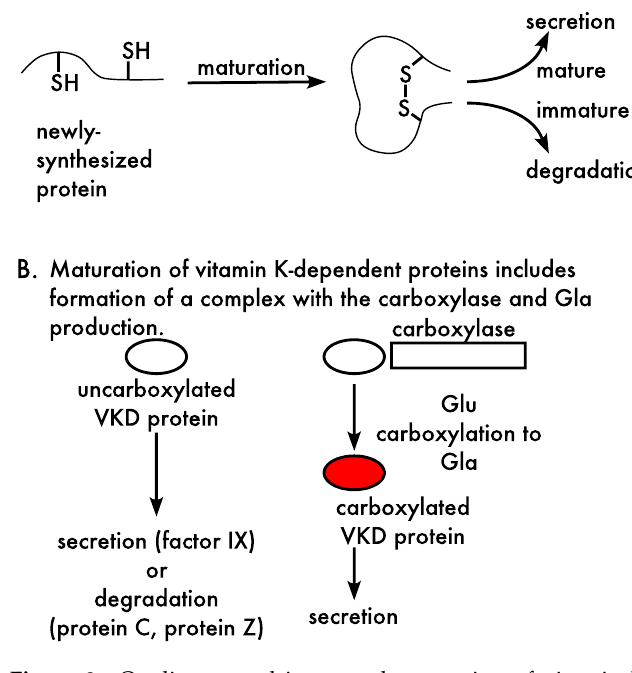
Figure 3. Quality control impacts the secretion of vitamin K-dependent proteins. ( A ) Newly-synthesized proteins undergo maturation that is mediated by chaperones and involves protein folding and, in some cases, disulfide bond formation and the assembly of complexes. Quality control mechanisms distinguish mature versus immature proteins, which are processed differently. Mature proteins exit the endoplasmic reticulum and traffic to the Golgi and beyond, while immature proteins are targeted for degradation through the ERAD pathway. ( B ) Vitamin K-dependent (VKD) protein maturation also includes Glu carboxylation to Gla that occurs in the endoplasmic reticulum. Cel- lular studies have shown that the fate of carboxylated and uncarboxylated proteins varies among individual VKD proteins. Specifically, both factor IX forms are secreted from cells, while only the carboxylated form is secreted in the case of protein C and protein